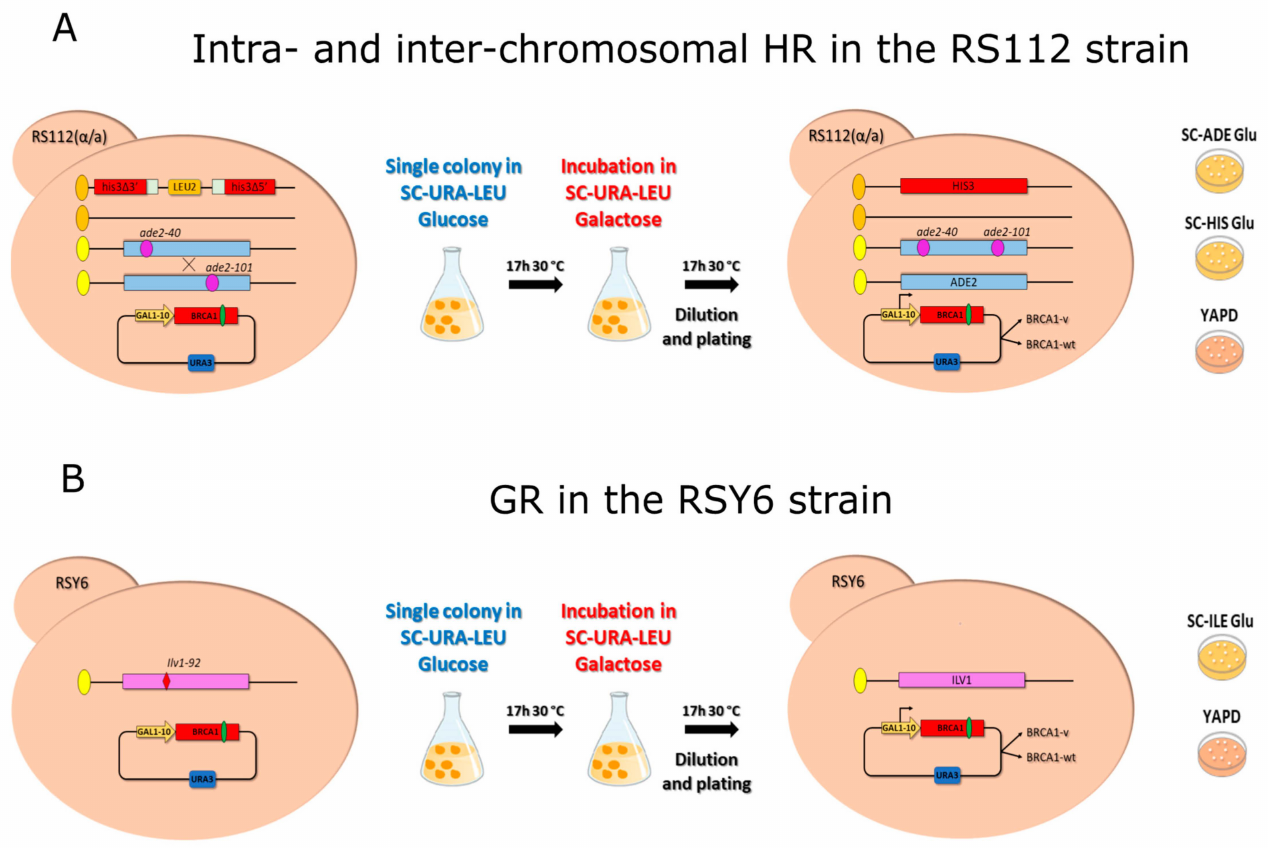
Figure 2. Description of the yeast-based functional assays. ( A ) HR assays were carried out in the diploid strain RS112. This strain contains the two his3 terminally deleted alleles separated by the LEU2 marker and by the plasmid sequence, respectively, and sharing 400 bp of homology. An intra-chromosomal HR event leads to HIS3 reversion with the loss of LEU2 marker. RS112 strain also has the alleles ade2-40 and ade2-101 which allow measuring inter-chromosomal HR events. ( B ) GR assay was performed in the haploid strain RSY6 that carries the ilv1-92, by direct counting the Ilv + colonies that were grown in synthetic complete medium lacking isoleucine (SC-ILE). Single colonies of the RS112 and RSY6 strain containing the plasmid-expressing BRCA1 protein or the empty vector were first pre-grown in glucose. Thereafter, 10 7 cells were inoculated in galactose medium, as described in the materials and methods; then the cells were counted and plated to score for cell surviving fraction, intra- and inter-chromosomal HR and GR